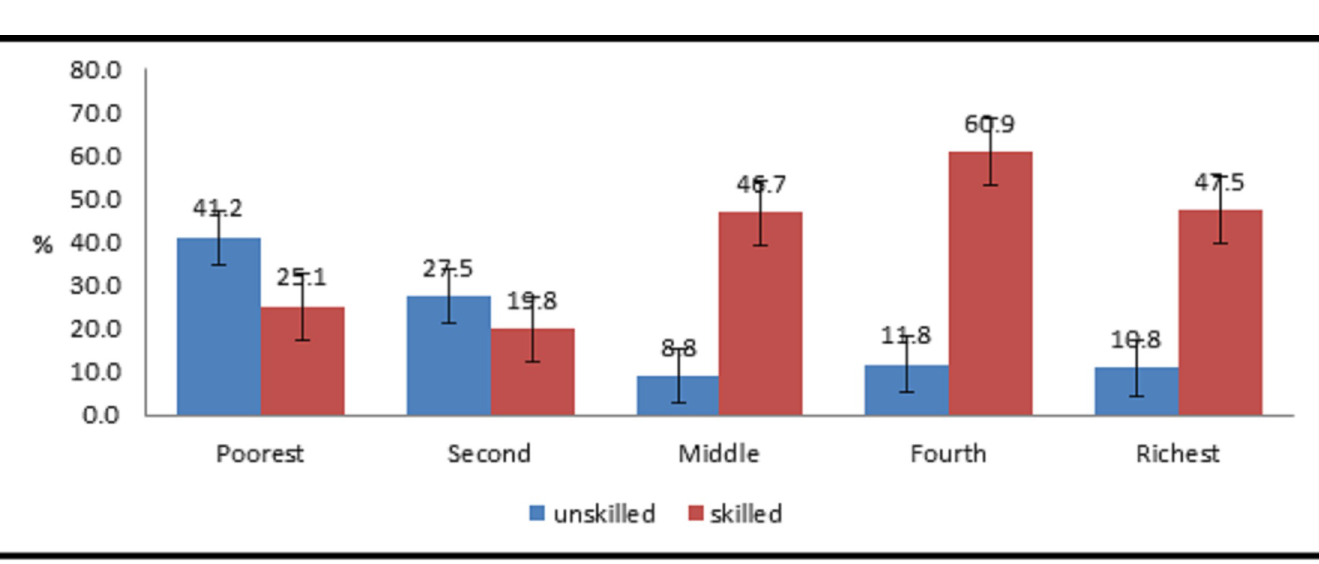
falling in poor SES category (poorest + second) as contrast to 45% in rich category (Richest + Fourth) of SES which is not a significant gap between these categories of SES. On the other side, in permanent category, 28% workers fall in rich SES (fourth + richest) category as com- pared to 55% in poor category (poorest + second) of SES. This behavior in this agglomeration of industry has some important reasons. Majority of these permanent workers are those who resides in their inherited houses located within surrounding buffers of industry. These workers have more than one earning sources, e.g. inherited agricultural land, part time jobs etc. which do not allow them to move away from their hometown. Furthermore, due to strong family